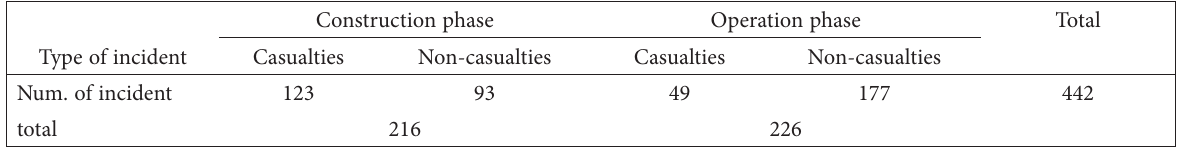
Table 1. Statistics of the collected subway incidents in China from 1971 to 2014 Construction phase